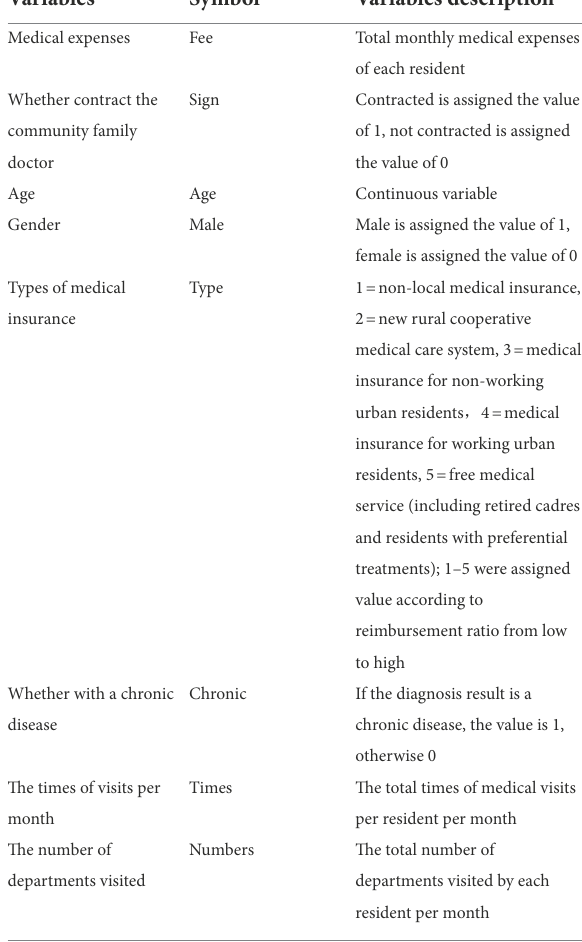
TABLE 1 Description of relevant variables.